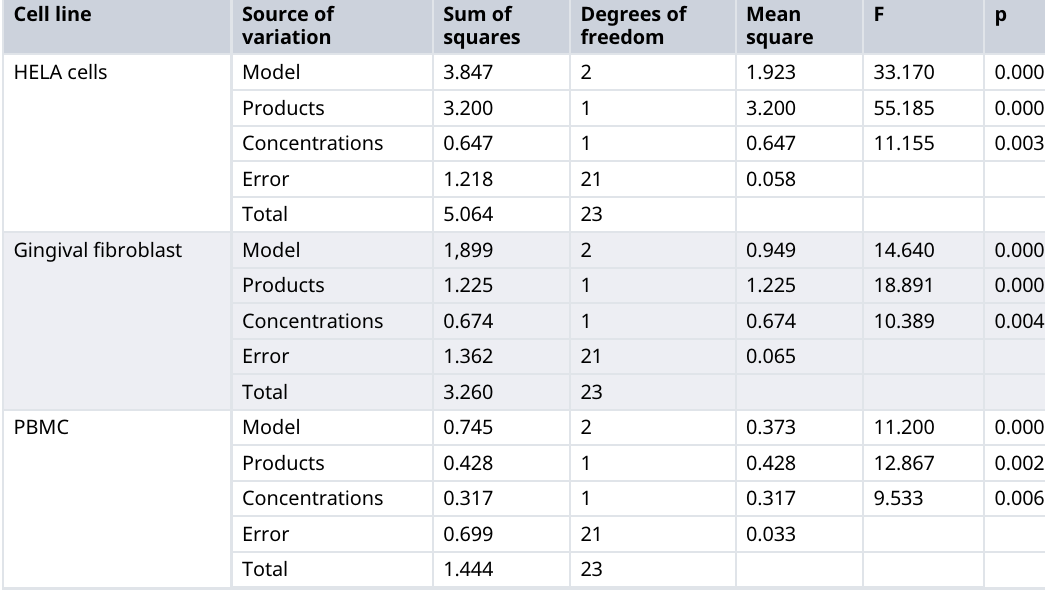
Table 1. Analysis of covariance cytotoxic effect of ethanolic extract concentrations of propolis and P. guajava on cell line viability. Cell